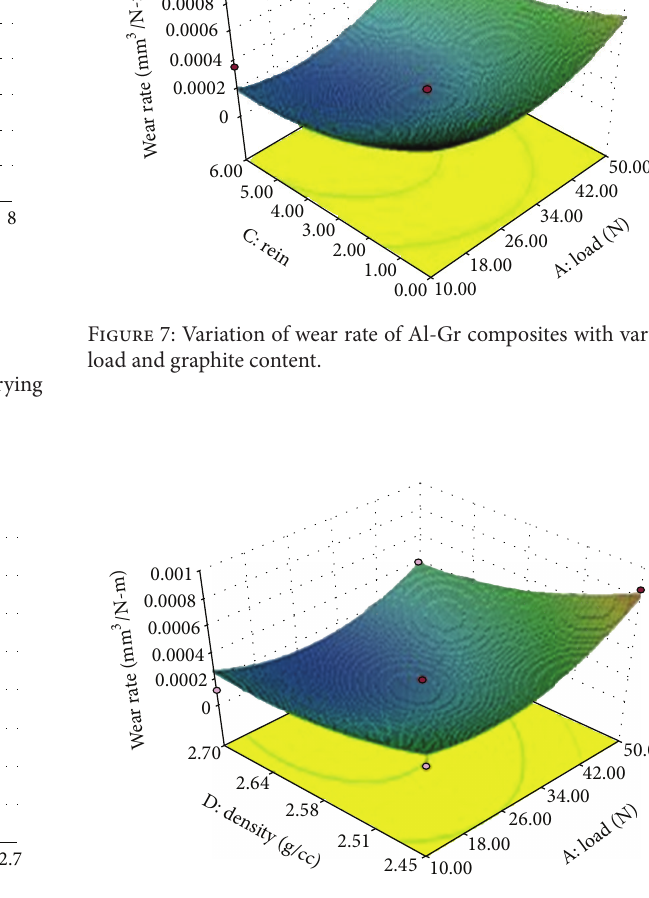
Figure 8: Variation wear rate of Al-Gr composites with varying load and density.